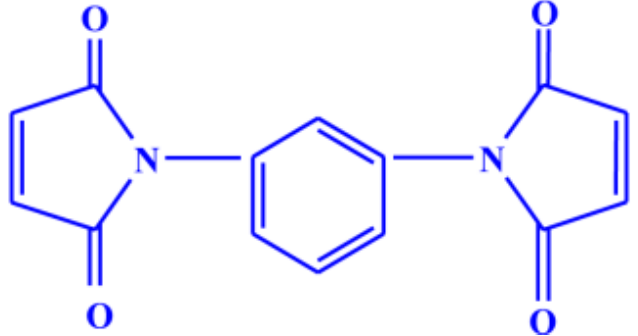
Figure 1. Chemical structure of N , N ′ -meta phenylene dimaleimide (Maleide F).